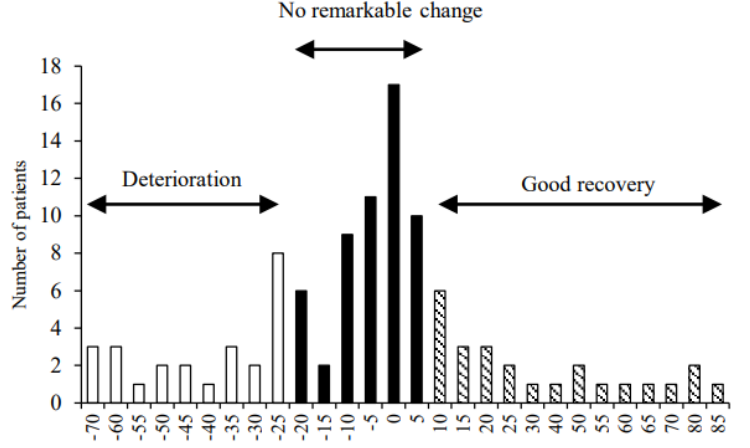
Figure 1. Category of three groups based on a quartile of variation of the Barthel index score: the 1st quartile (deterioration group, n = 25), the interquartile range (no remarkable change group, n = 55), and the 3rd quartile (good recovery group, n = 25).